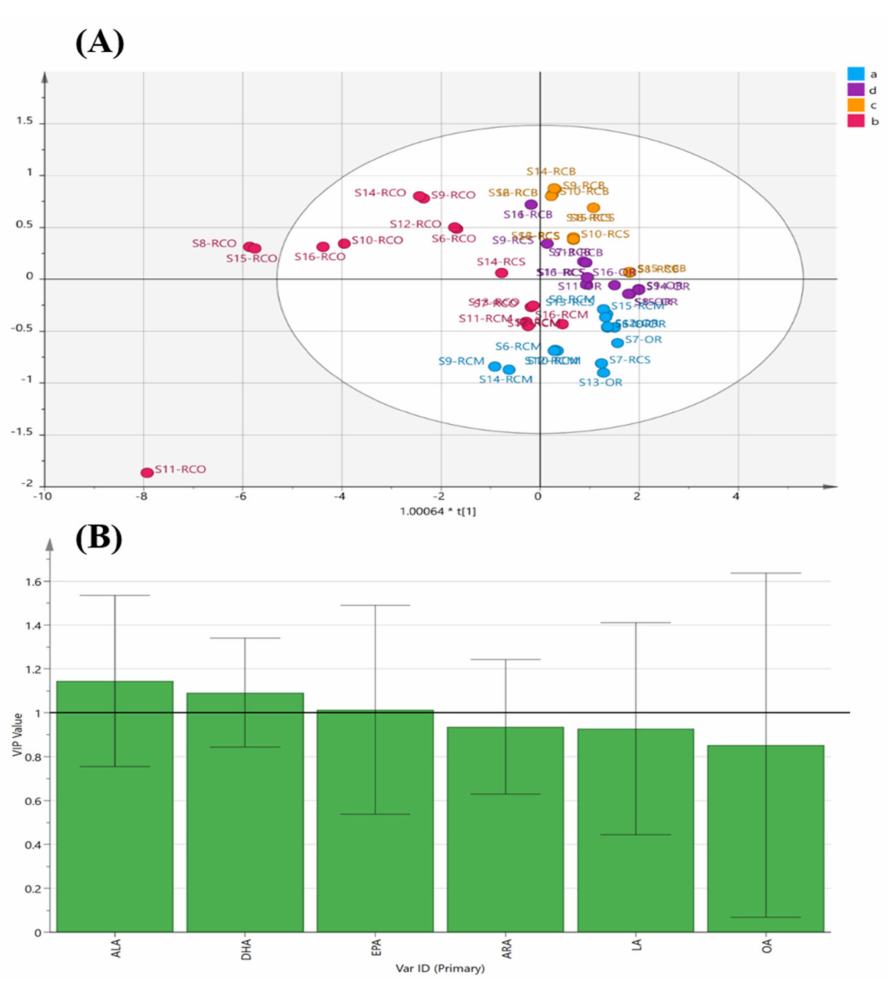
Figure 10. Supervised pattern recognition model. ( A ) The OPLS-DA score plot of the different tissue of Rana chensinensis. ( B ) The variable importance for the project (VIP) plot of